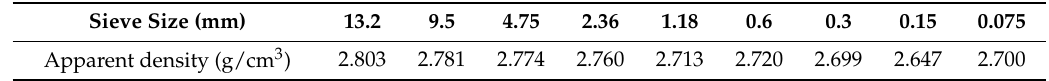
Table 2. Physical properties of the aggregates.